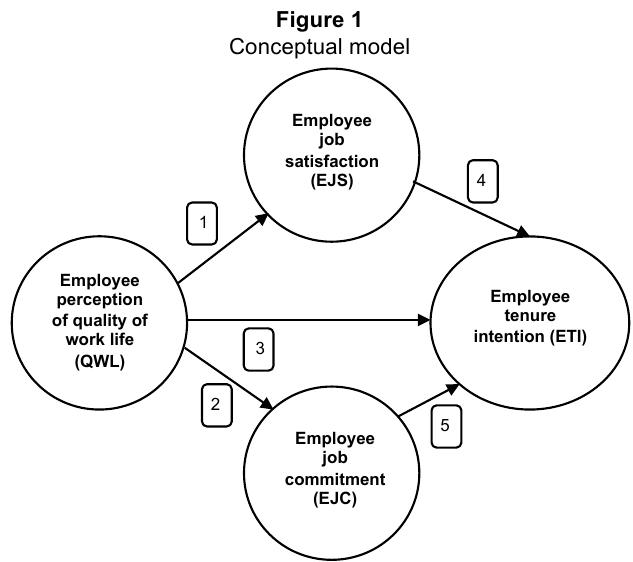
Conceptual model Employee